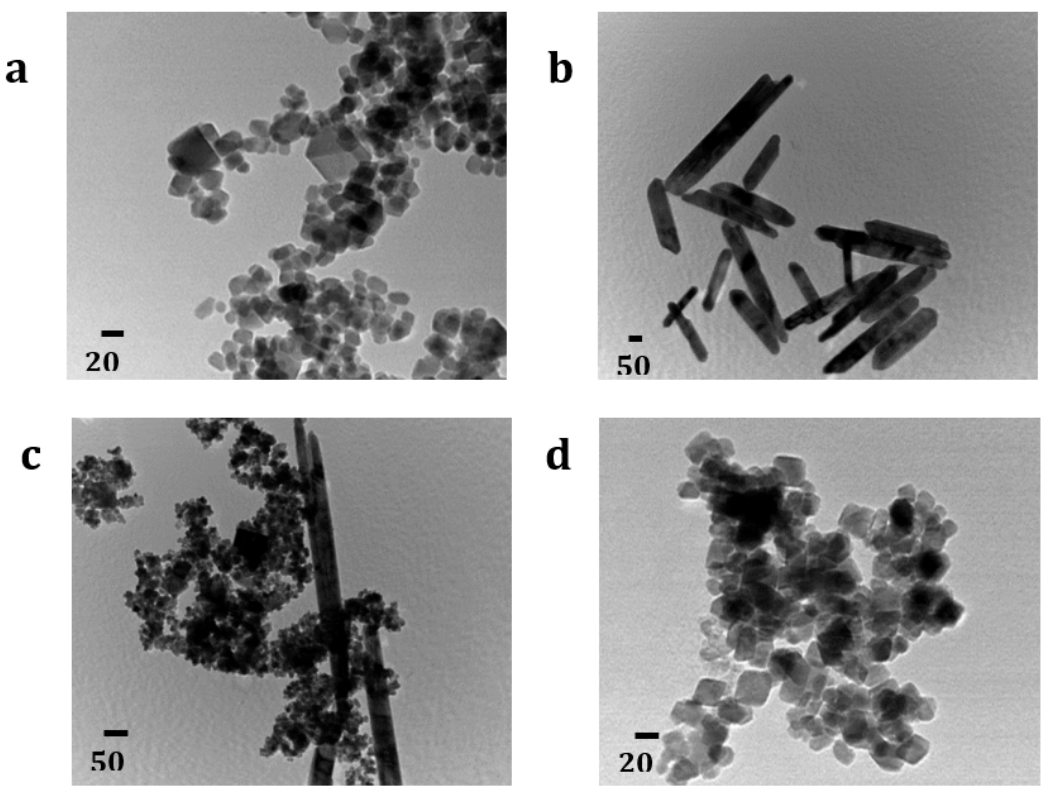
Figure 3. TEM micrographs of ( a ) Mag@PEG, ( b ) Gd(OH) 3 Nps, ( c ) and ( d ) Mag@Gd(OH) 3 .